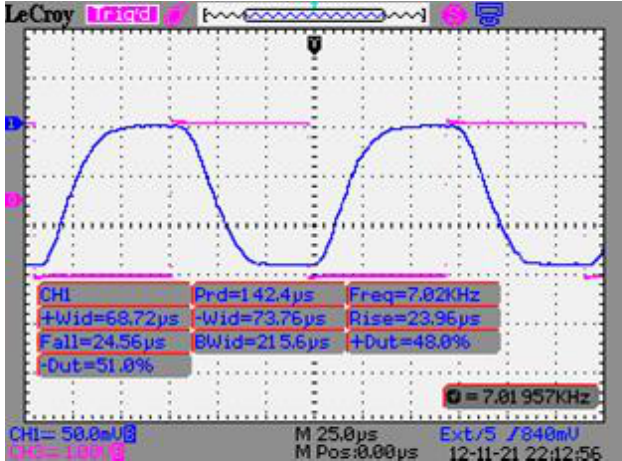
Figure 8. Oscillogram of the bipolar control voltage (zero level — digit 3) and optical response (zero level — digit 1) for an electro-optical cell with composition HF-32C at the voltage amplitude of ±1.5 V and frequency of 7.0 kHz. The upper level of the optical response is the closed state; the lower one is the light transmission state.